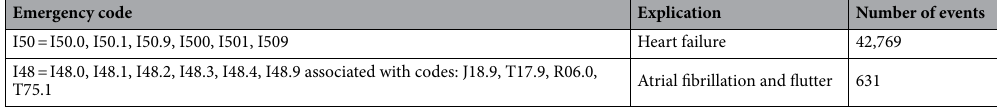
Table 1. Inclusion codes for patient